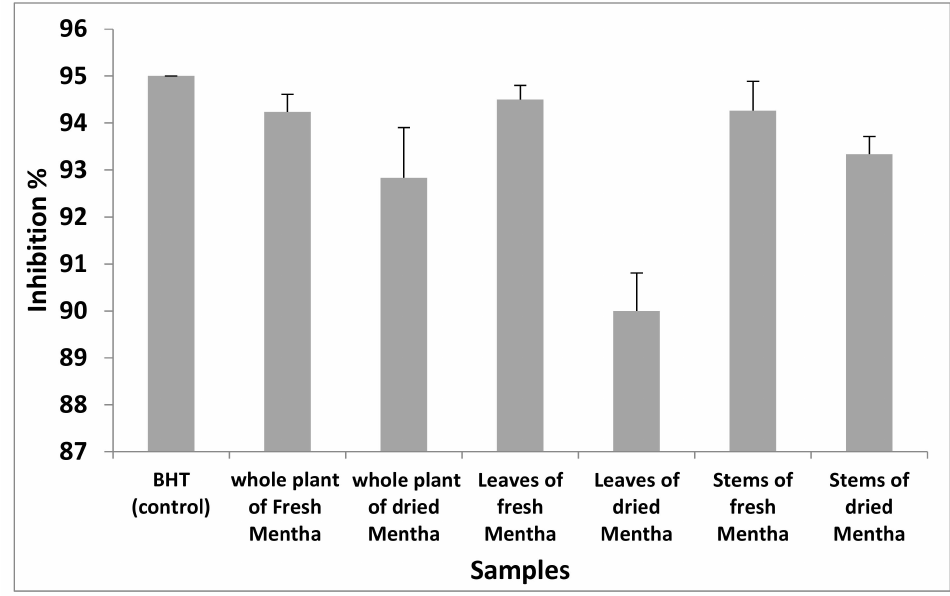
Figure 3. Antioxidant activity of non-volatile constituents of M. suaveolens